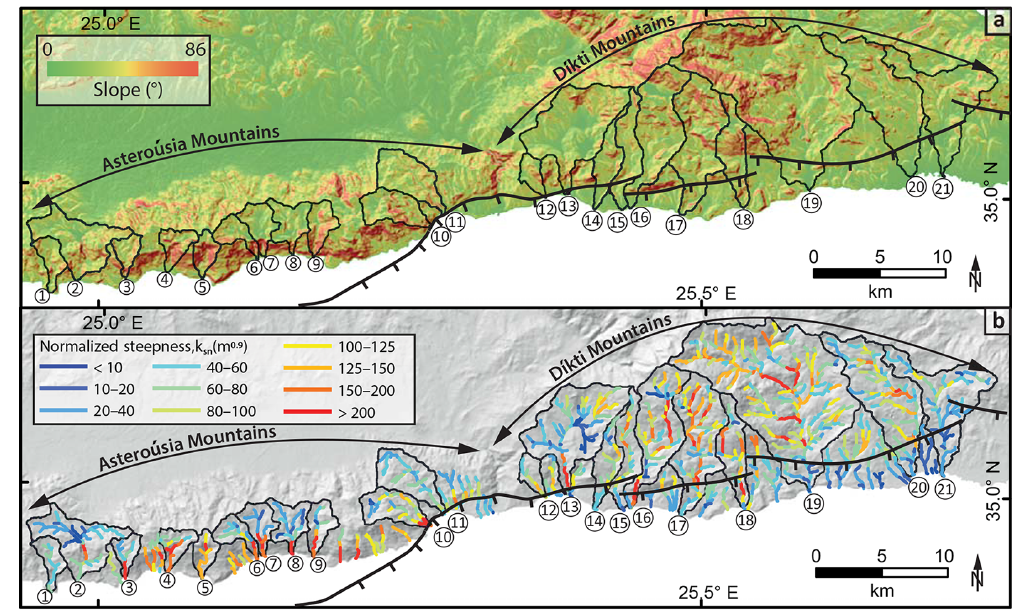
Figure 4. (a) Map of the slope distribution overlain with the location of active faults and the 21 drainage basins analyzed in this study (black polygons). (b) Normalized steepness index ( k sn ) map of the channels that drain >0.1km 2 area for the 21 basins investigated in this